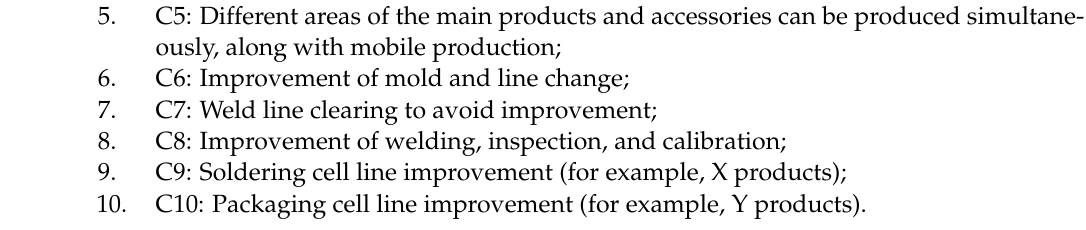
Table 5. C1 improvement project and its improvement effects (before and after).